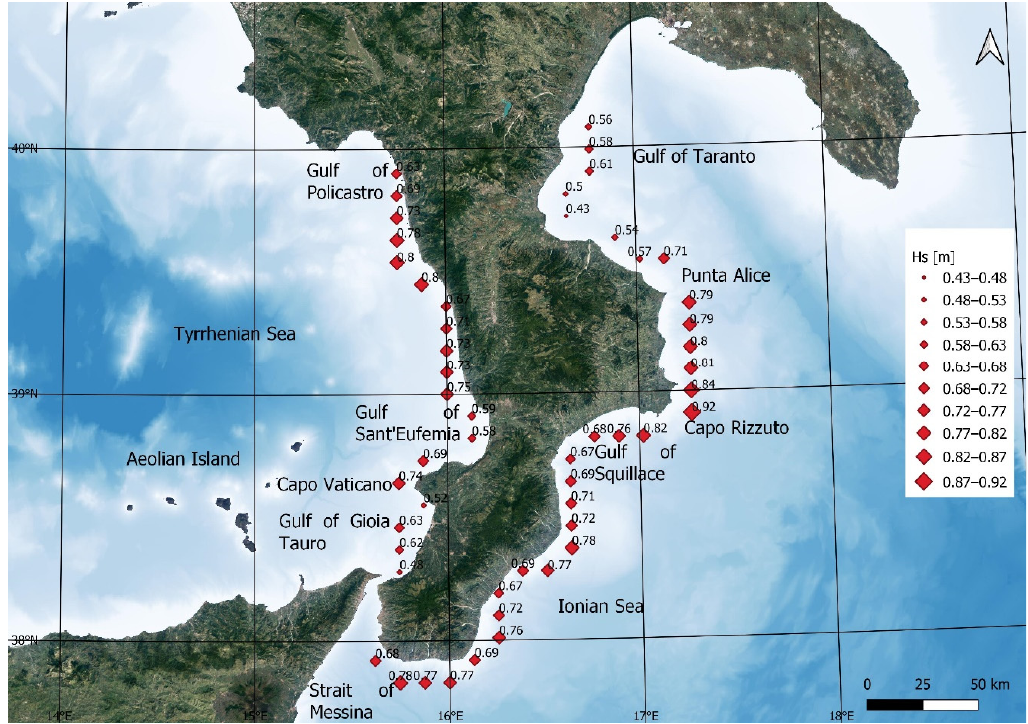
Figure 4. Average significant wave height h s values. The range between the minimum and the maximum values has been divided into 10 intervals of the same width.